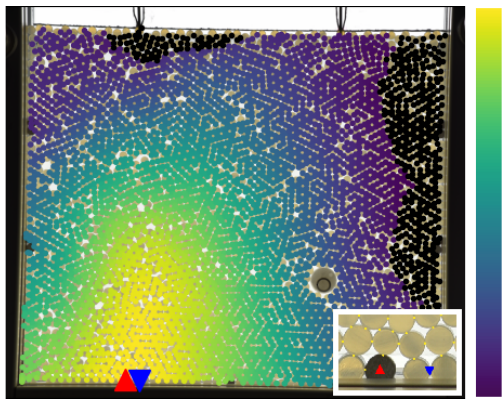
Figure 4. Full probability map with the information of each sen- sor pair agglomerated through product pooling. The maximum is located very close ( ∼ 2 diameters) to the actual initial impact, as shown in the zoomed insert. Black contacts (o ff the scale) have been rounded down to exactly 0 by the